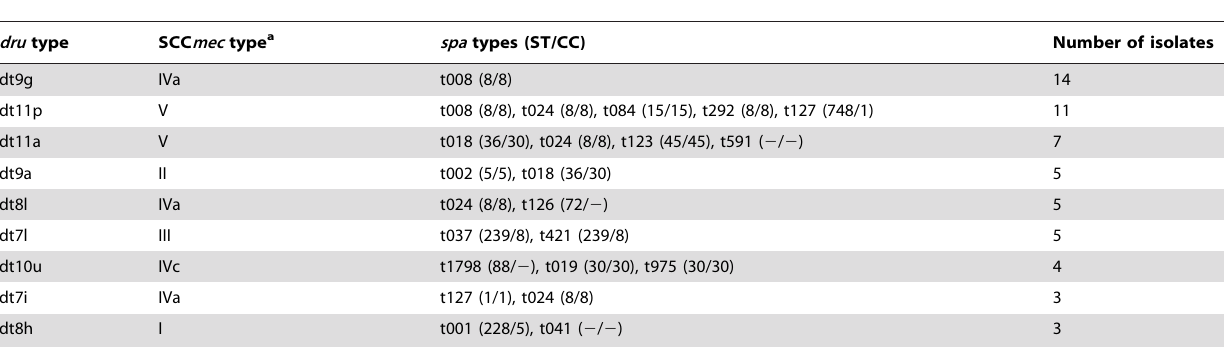
Table 2. dru types found in more than two isolates and restricted to one SCC mec